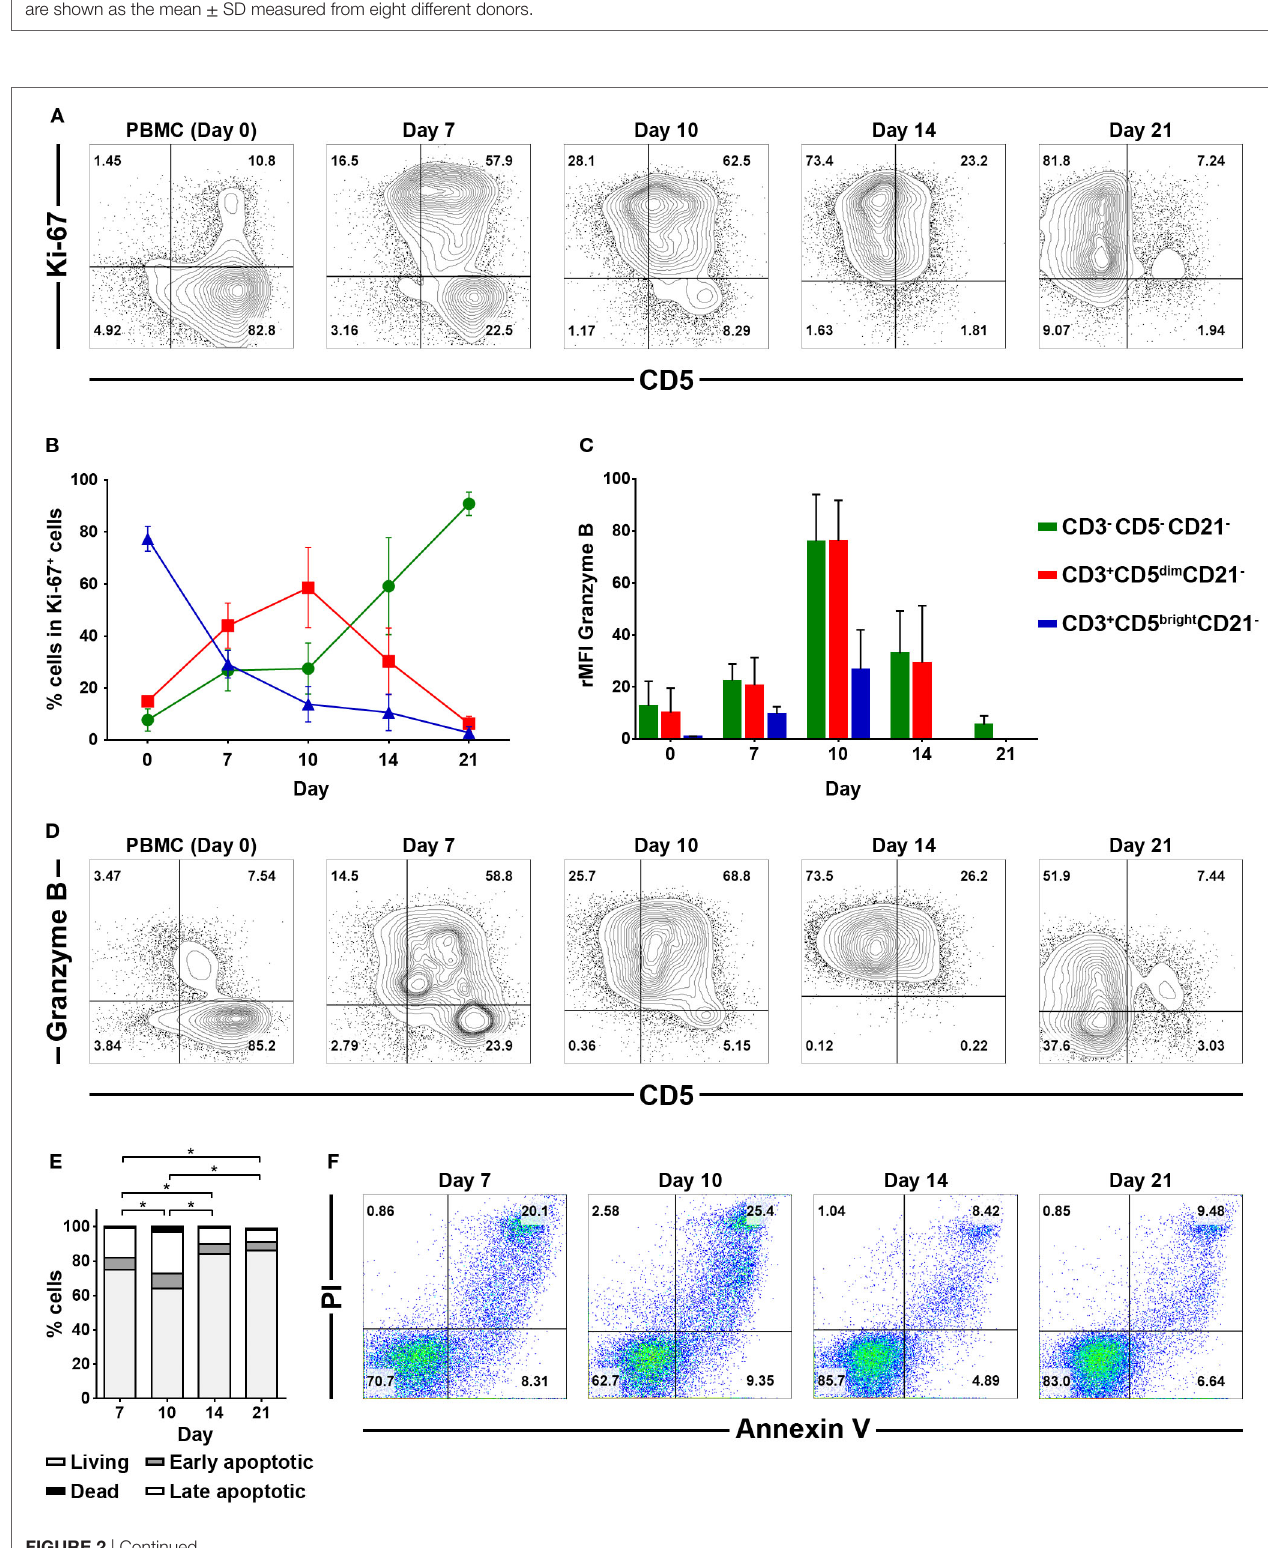
FigUre 1 | Analysis of lymphocyte subpopulations during ex vivo expansion in the presence of 100-Gy-irradiated K562 cells, interleukin (IL)-2, IL-15, and IL-21. (a) Representative flow cytometry data ( n = 8), and (B) lymphocyte subpopulation dynamics showing changes in the frequency of CD3 − CD5 − CD21 −